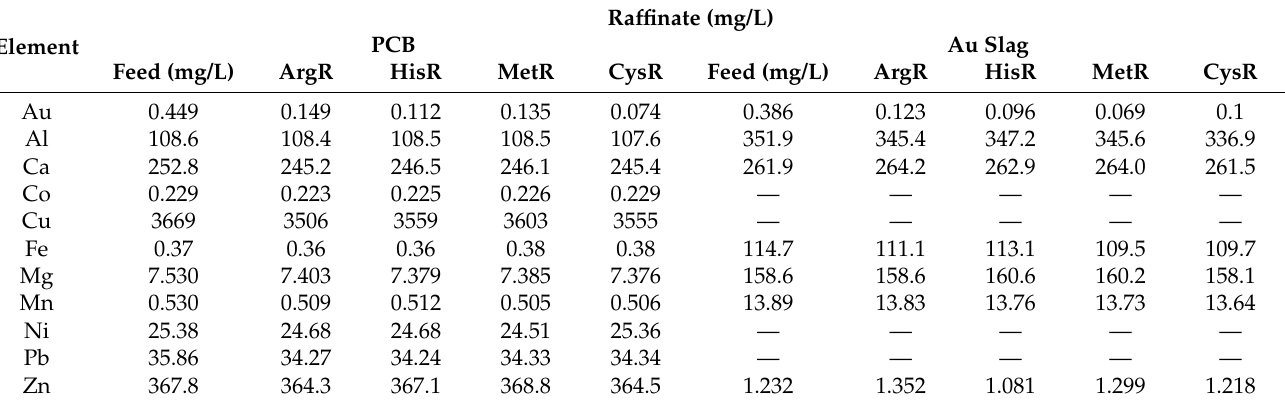
Table 5. The composition of leaching solution before and after ArgR, HisR, MetR, and CysR